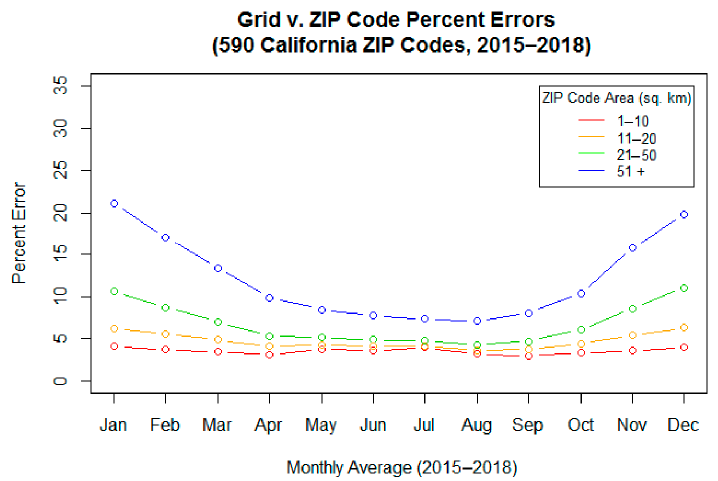
Figure 5. Plot of relative percent differences (RPDs) between 1 km 2 resolution PM 2.5 estimates and their corresponding ZIP Codes averages by ZIP Code size (590 California ZIP Codes from 92 cities, 2015–2018). Table 2. PM 2.5 concentrations and coefficient of variation (CV) by region, season, and ZIP Code size for 590 California ZIP Codes from 92 cities. The coefficient of variation (CV) represents the relative